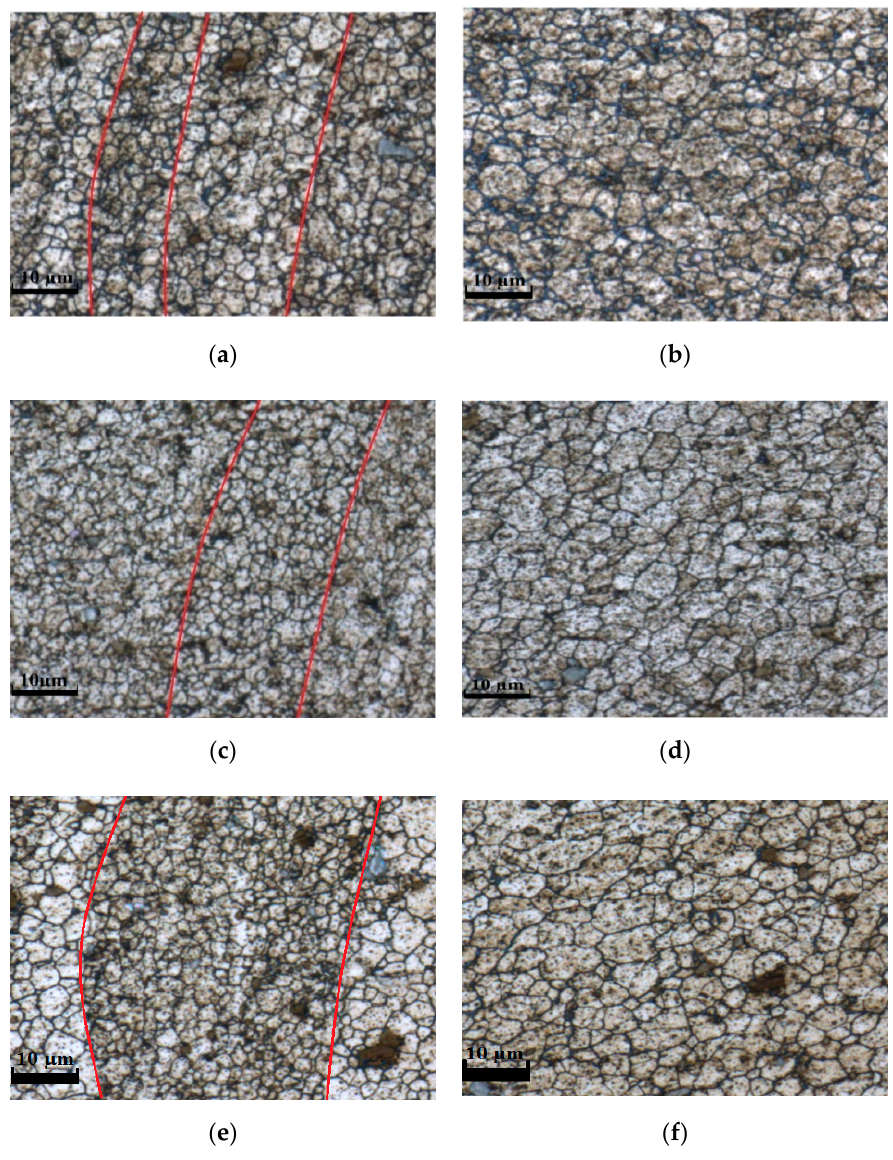
Figure 5. ( a , c , e ) are onion rings; ( b , d , f ) are areas in the retreating side in samples T1, T3, and T4, respectively.